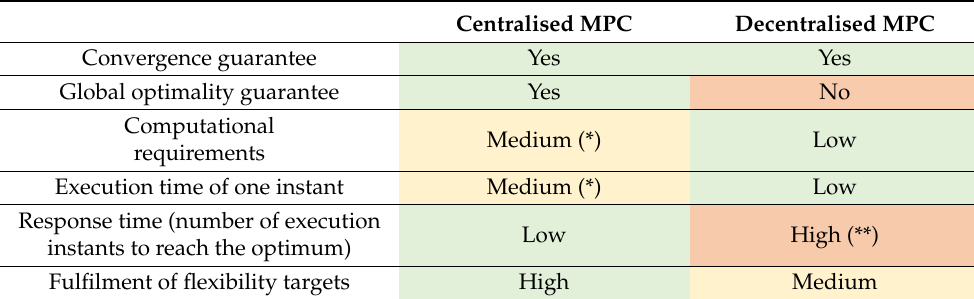
Table 1. Comparison between centralised MPC and decentralised Figure 14. Examples of demand response services.